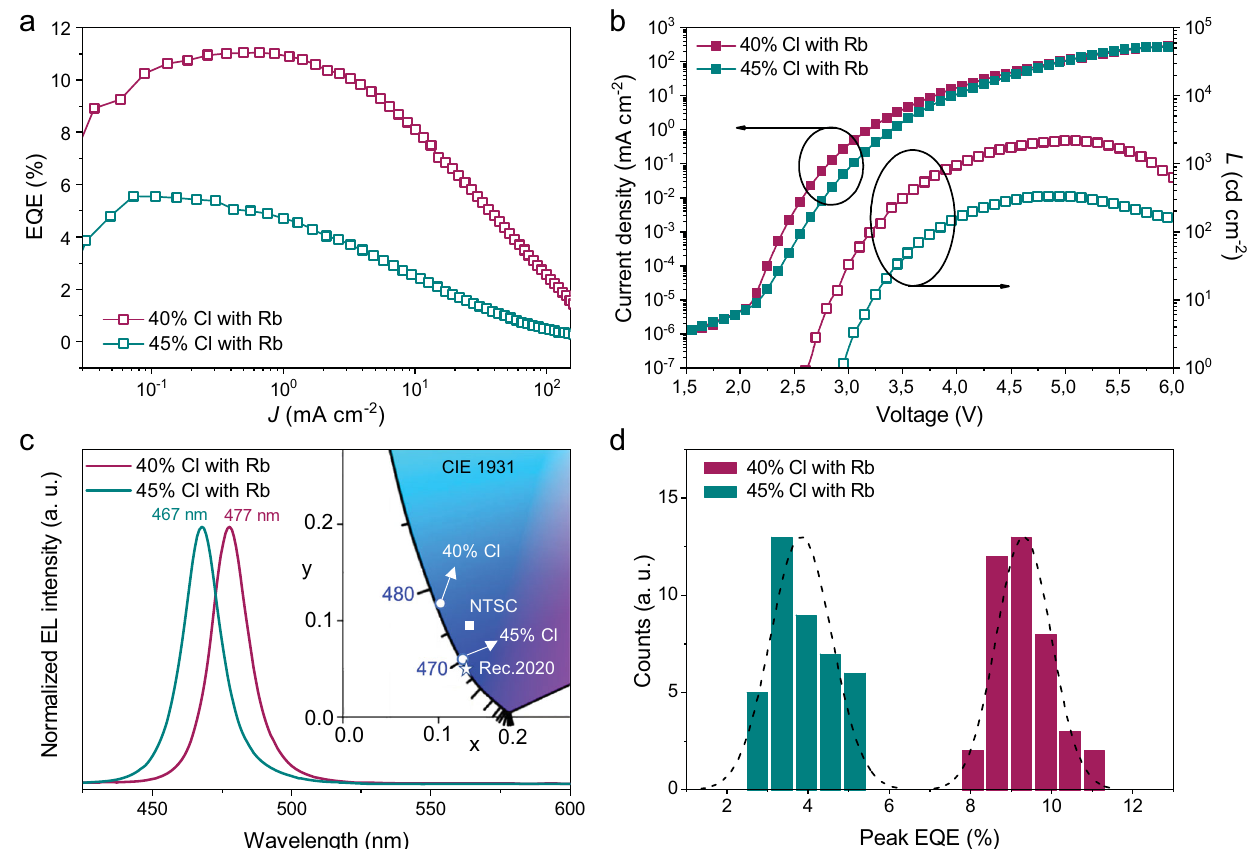
Fig. 4 The device performance of Rb-passivated perovskites with 40% and 45% Cl contents. a EQE-current density ( J ) curves ( J -EQE). b Current density – voltage – luminance ( J – V – L ) characteristics. c EL spectra and CIE colour coordinates. The square and pentagram in the CIE 1931 (x, y) chromaticity diagram represent the colour coordinates of primary blue speci fi ed in the National Television System Committee (NTSC) and recommendation bt.2020 (Rec.2020), respectively. d Histograms of the peak EQEs extracted from 40 devices for each